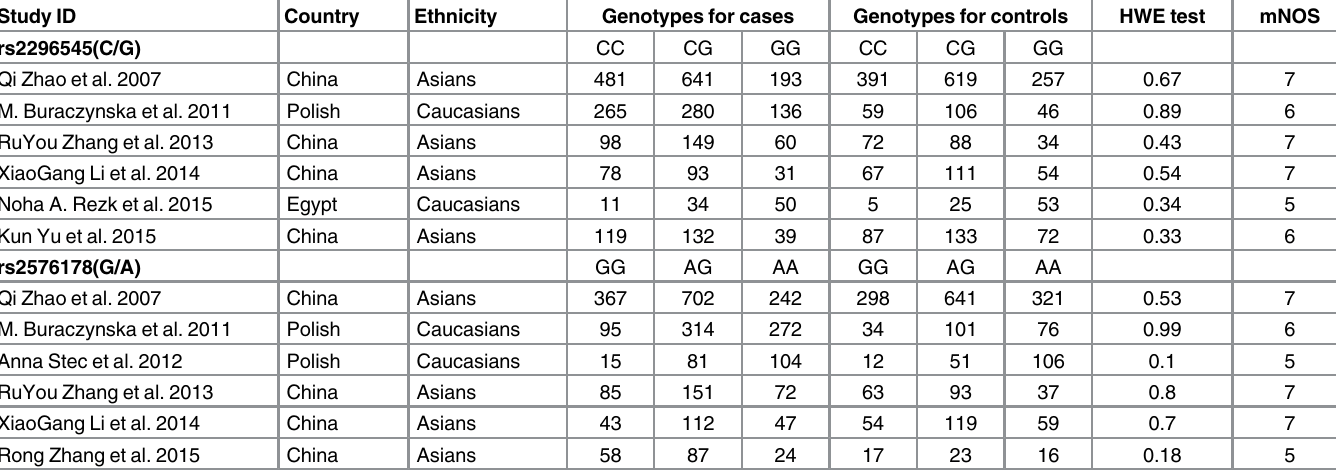
Table 1. Characteristics of studies included in the